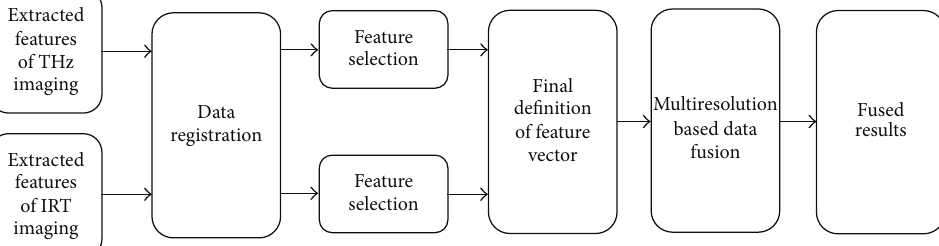
Figure 7: The functional block diagram of the data fusion process.